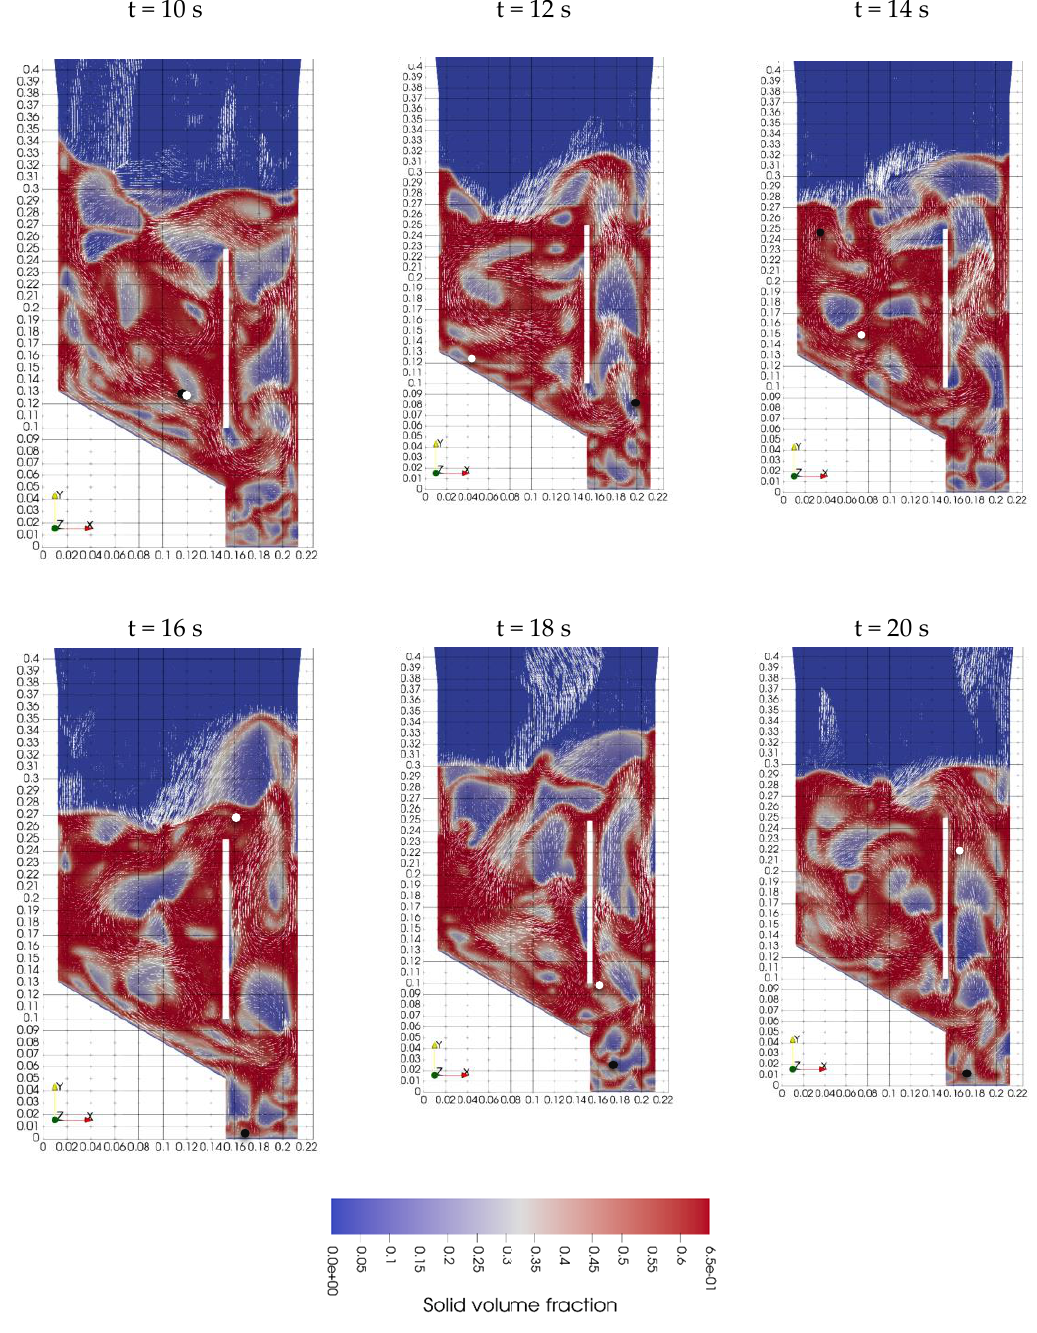
Figure 13. Visual representation of equivalent char particles position inside cold model reactor at di ff erent simulation time: white dot for particle of diameter d p = 0.22 mm; black dot for particle of diameter d p = 0.27 mm. Images also show the instantaneous granular solid phase volume fraction and the solid velocity field.